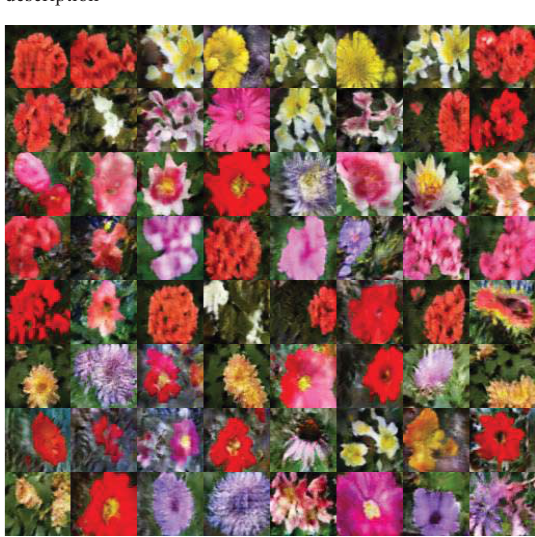
Fig. 8. GAN generated image for the above text